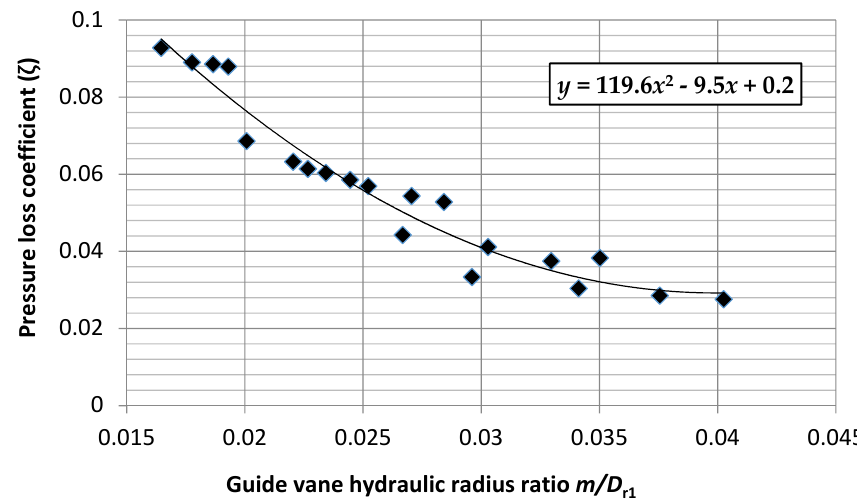
Figure 4. Relation of the pressure loss coefficient and guide vane hydraulic radius ratio.